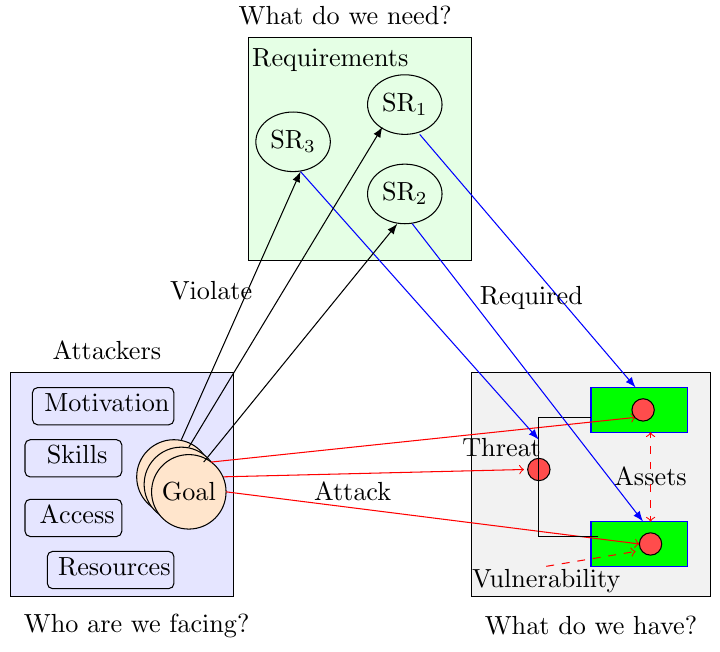
Figure 2. Software, Asset, Vulnerability, Threat, and Attacker (SAVTA) threat